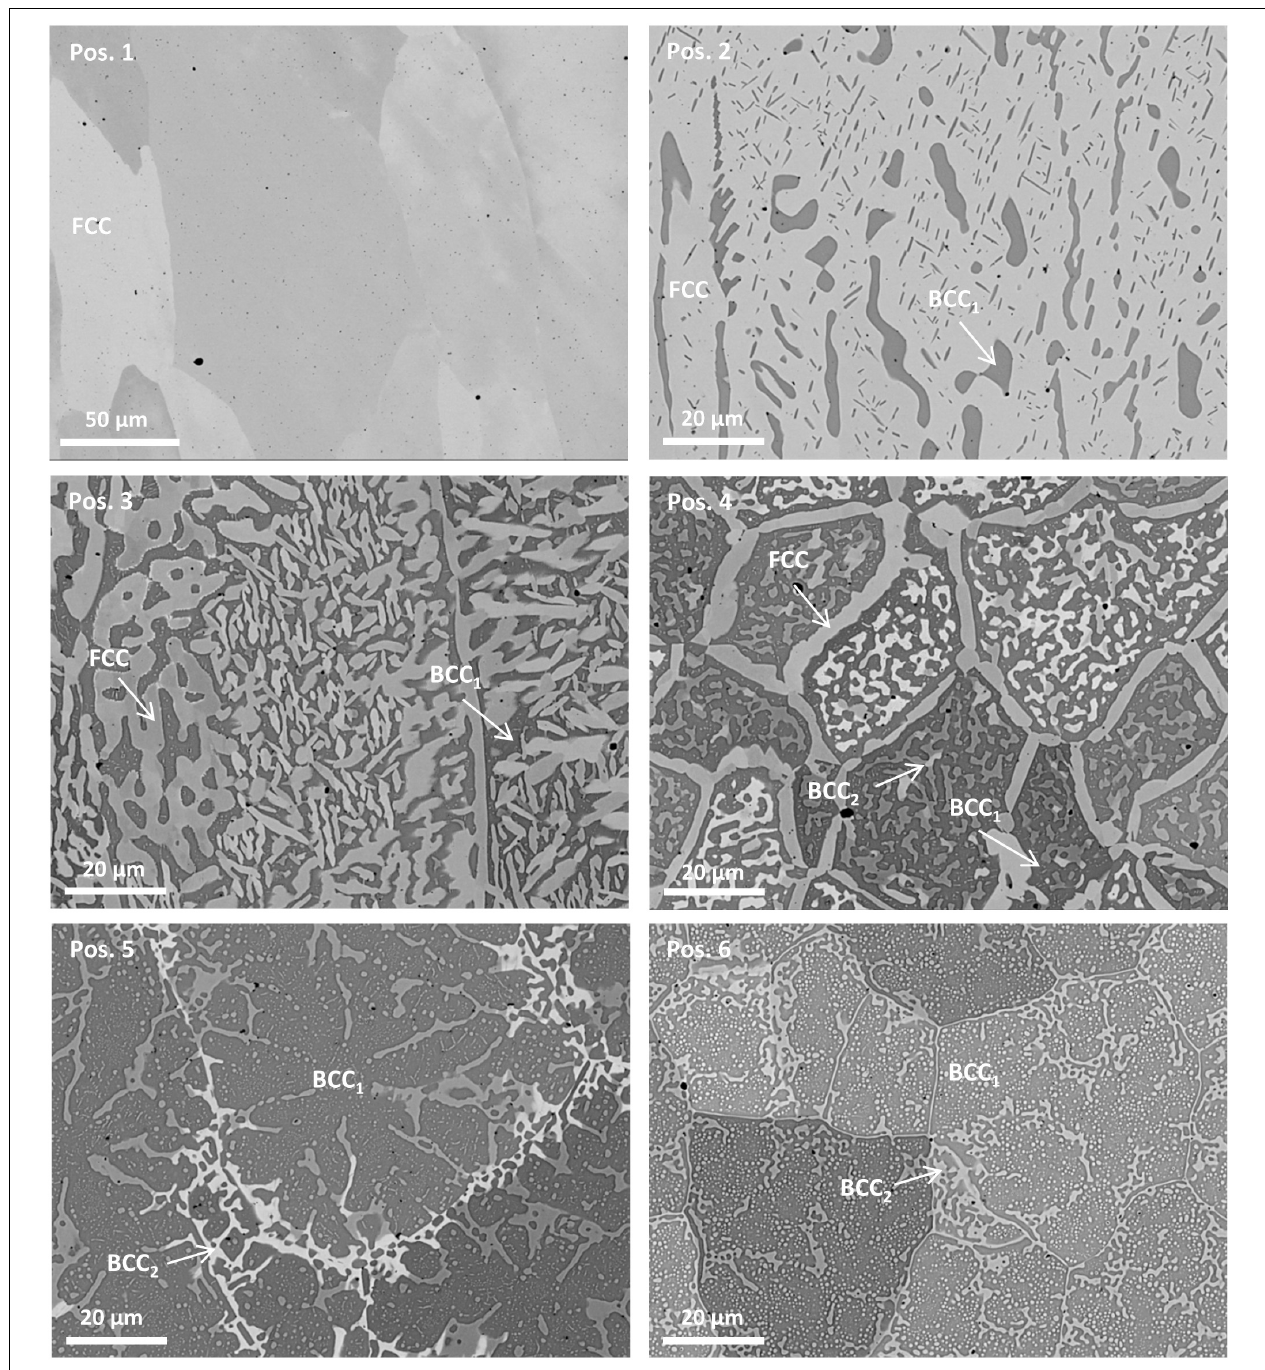
FIGURE 9 | SEM images of the major microstructures of the samples after heat treatment with increasing Al content derived from all three cladded gradients: Pos. 1 at 4.8 at.% Al, Pos. 2 at 10.4 at.% Al, Pos. 3 at 14.7 at.% Al, Pos. 4 at 17.5 at.% Al, Pos. 5 at 23.5 at.% Al, and Pos. 6 at 24.6 at.% Al.